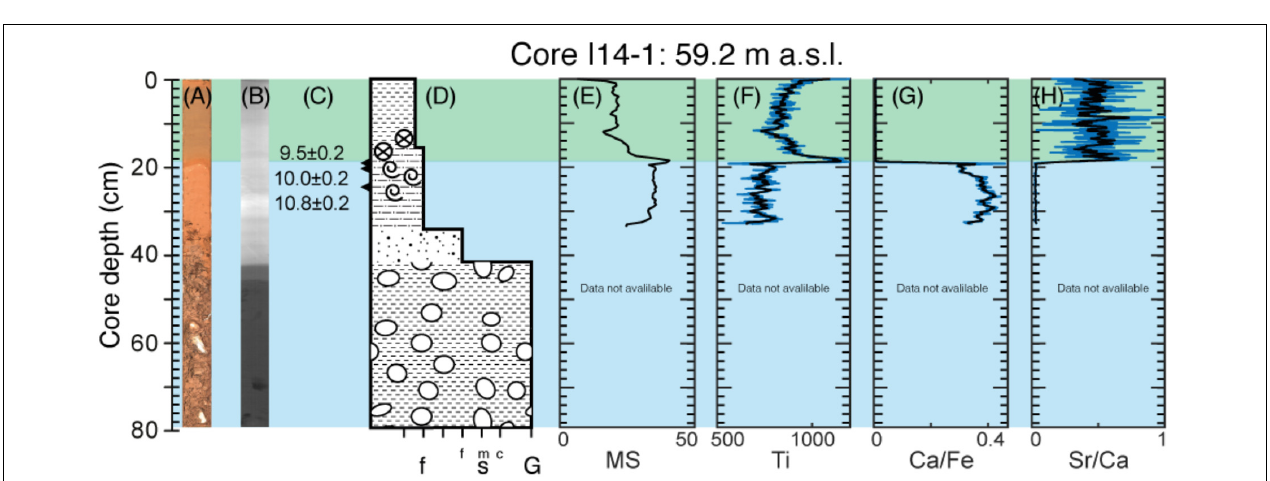
FIGURE 3 | Overview of Core I14-1. (A) High-resolution image of the core. (B) X-ray image. (C) Age and position of radiocarbon dates from foraminifera (black triangles). (D) Lithologic log with grain sizes from fines (clay, silt) to sand and gravel. (E–H) Magnetic susceptibility measurement and content of Ti; Ca to Fe ratio; Sr to Ca ratio. Blue background color indicates marine conditions, green indicates lacustrine. Refer to Figure 2 for legend.